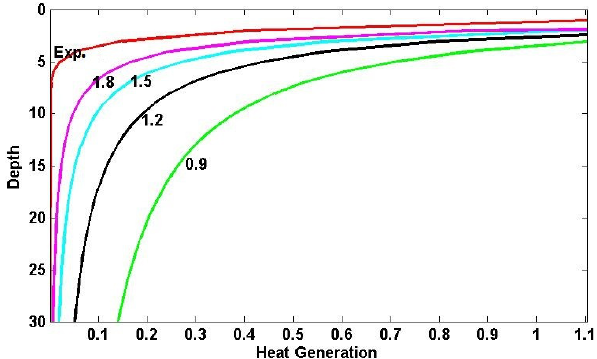
Fig. 7. Theoretical decay of exponential function (shown in red) and power law (for exponents 0.9,1.2,1.5 and 1.8 shown in green, black, cyan, and magenta respectively) with depth. Exponential function exhibits steeper decay than any power law exponent. This figure substantiates that the heat production decay follows power law as exponential decay is too steep to be real. This implies that less heat flow would be generated by radiogenic elements within the crust, if exponential model is assumed.